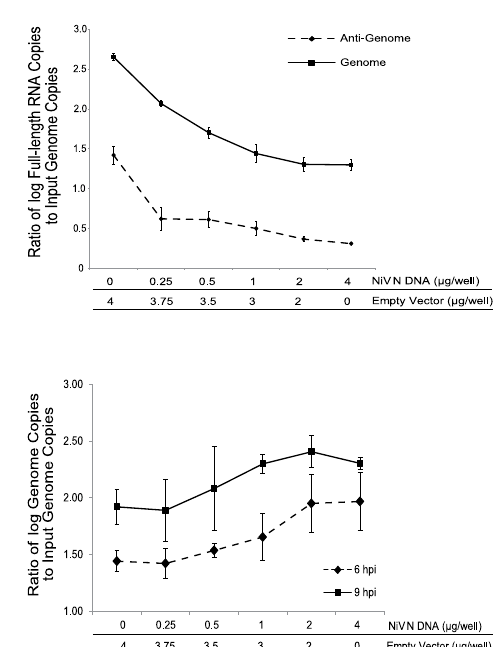
Figure 6. Effects of recombinant NiV N expression on input polymerase activity. Cells were transfected with increasing amounts of plasmid DNA encoding the NiV N gene. Total RNA was extracted from infected cells at ( a ) 24 hpi, ( b ) 0, 6 and 9 hpi, and 1 µ g of RNA was analyzed by strand-specific RT and real-time PCR spanning the intergenic region between the NiV G and L genes. Each reaction was standardized to the input genome copy number after